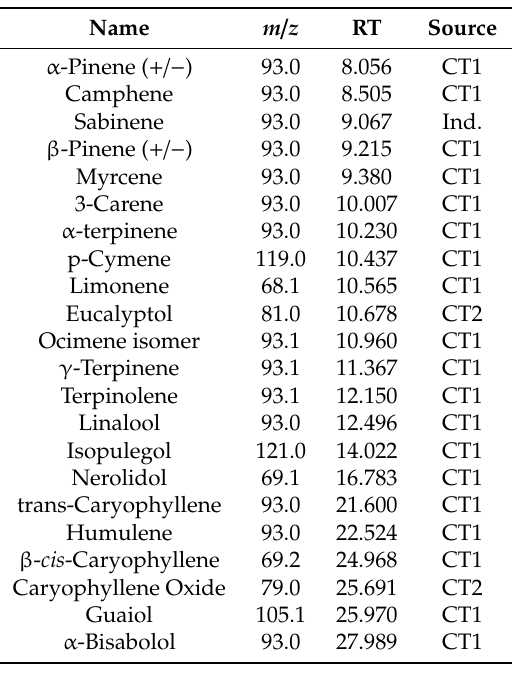
Table 5. Compounds used for method validation. Names, base peak ions ( m / z ), retention times (RT), and source are given. CT1: Restek cannabis terpenes standard mix #1 CT2: Restek cannabis terpenes standard mix #2, ind: individual standard